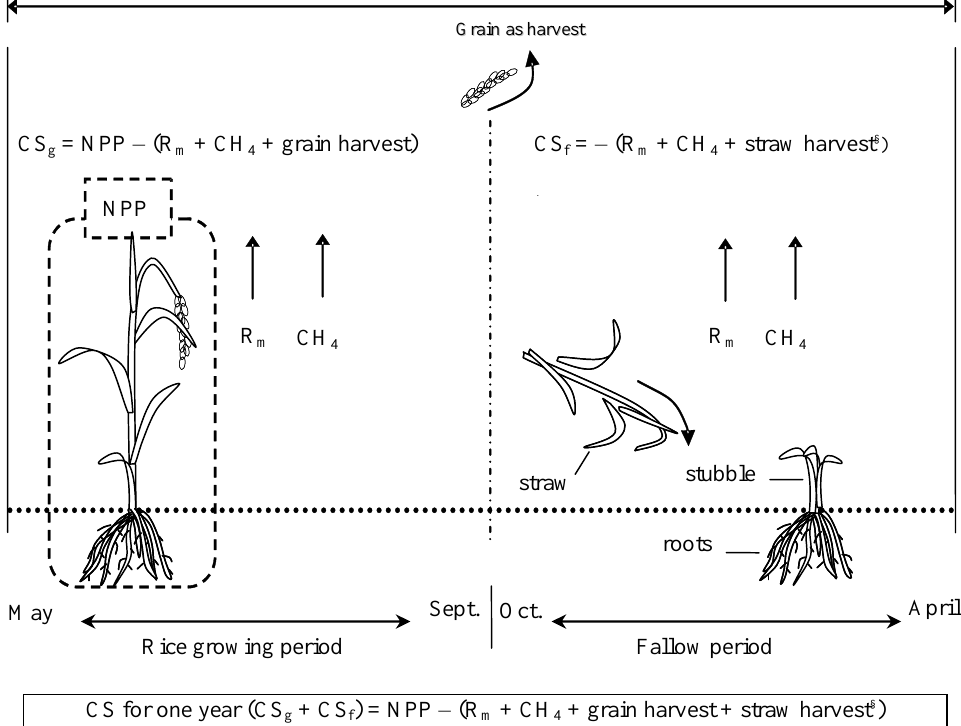
Figure 2. Schematic diagram of carbon sequestration (CS) estimation procedure. § Straw harvest depends on management. For example, if farmer leftover all harvested straw on field that time “straw harvest = 0”.